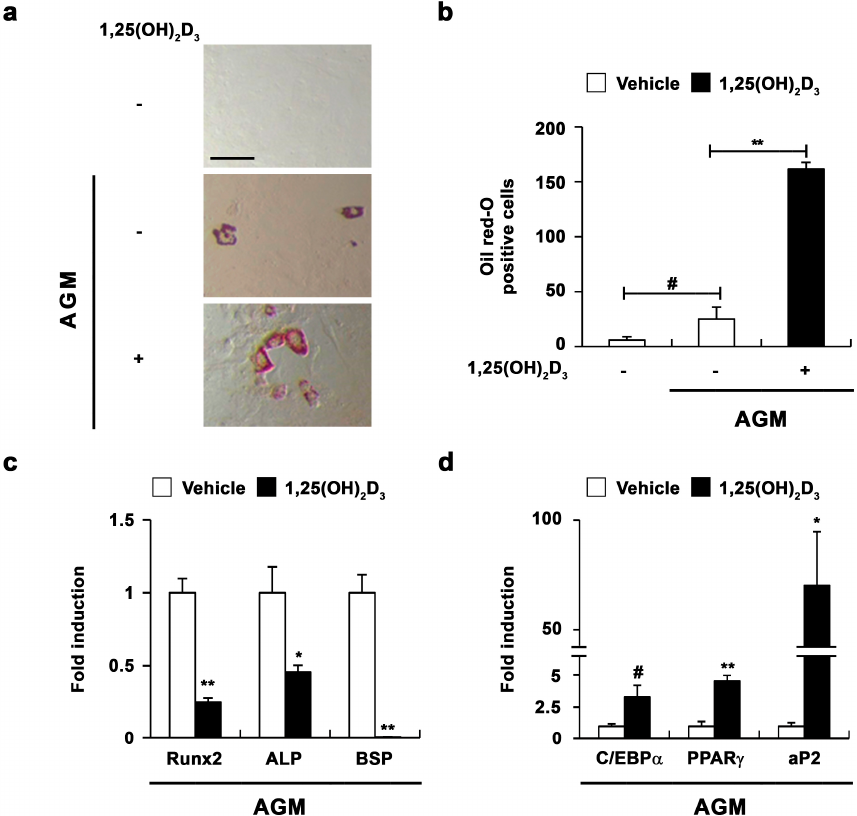
Figure 4. 1,25(OH) 2 D 3 induces adipocyte differentiation in primary osteoblasts. ( a – d ) Primary osteoblasts were cultured in adipogenic medium (AGM) containing either vehicle or 1,25(OH) 2 D 3 (10 − 8 M). ( a ) Cultured cells were fixed and stained with Oil Red-O, Bar: 50 µm; ( b ) The number of Oil Red-O—positive cells was counted; ( c ) The mRNA levels of Runx2 , ALP , and BSP were analyzed by real-time PCR; ( d ) The mRNA levels of CEBP - α , PPAR - γ , and aP2 were analyzed by real-time PCR. # p < 0.05; * p < 0.01; ** p < 0.001 as compared with controls.